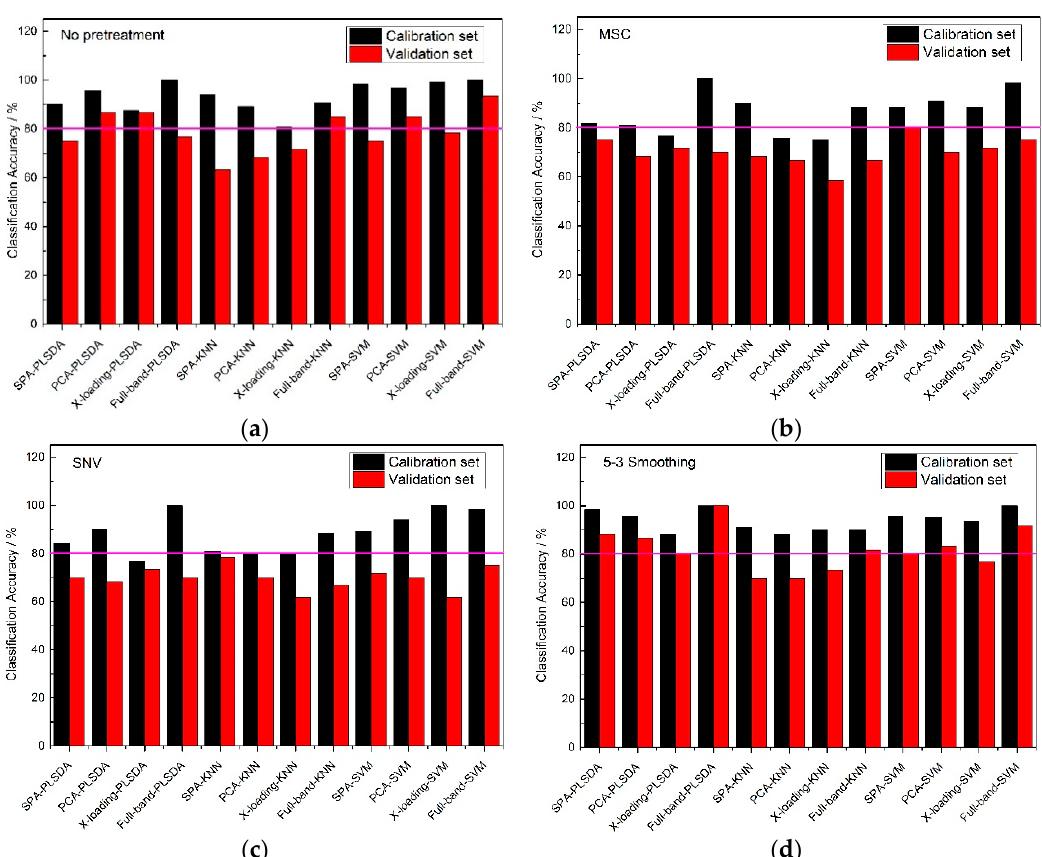
Figure 4. The classification accuracy results of Haoyu21 with ( a ) no pretreatment method, ( b ) the MSC pretreatment method, ( c ) the SNV pretreatment method and ( d ) the 5-3 smoothing pretreatment